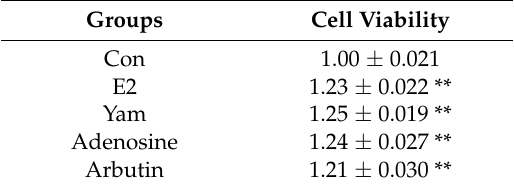
Table 5. Effect of mouse serum on the proliferation of MCF-7 cells (x ± SD, n = 4). Groups